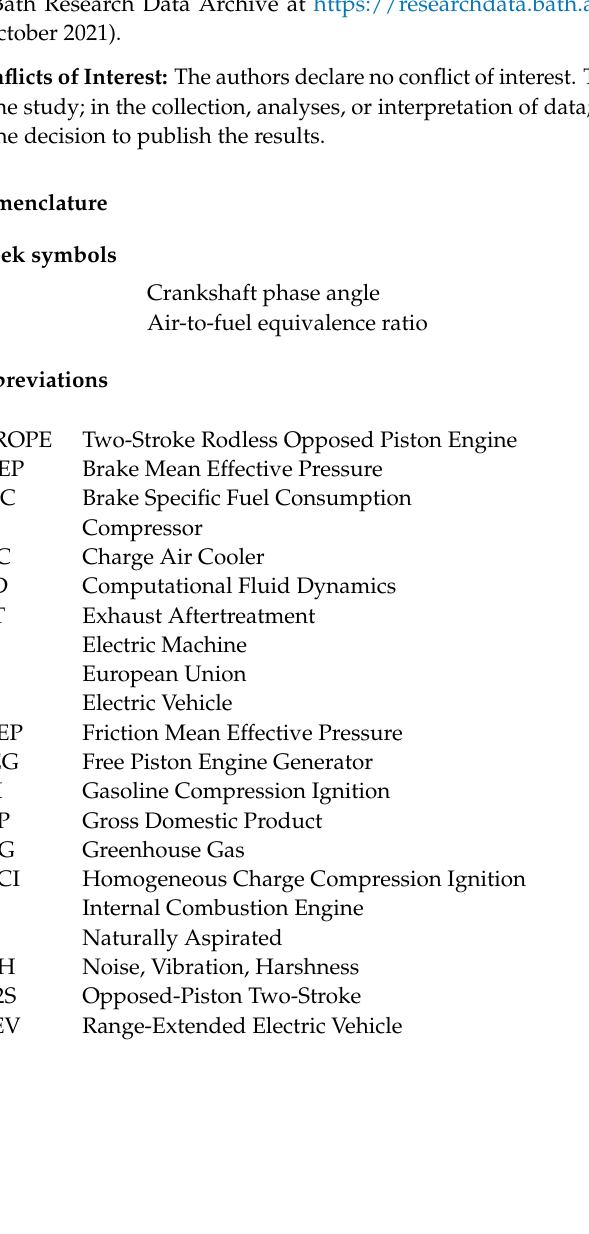
Figure 3. Schematic representation of OP2S engine configuration with electric compressor (C, top left), using electrical power transmission as the method of variable-speed drive. CAC: charge air cooler; EM: electric machine; EAT: exhaust